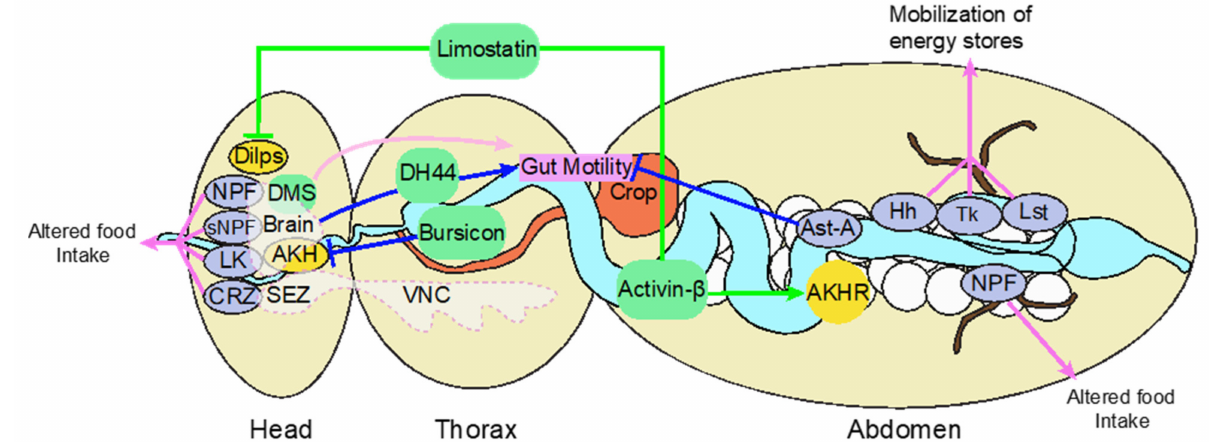
Figure 2. The fly gut is a major organ involved in nutrient-sensing to maintain metabolic homeostasis. The gut secretes multiple hormones and receives information from brain-derived hormones. These signals regulate functions, including gut motility, mobilization, and food intake. Thus, these hormones regulate the nutrients availability. Brain-derived peptides including Crz, DMS, Lk, NPF, sNPF regulate food intake, thereby regulating the quantity of nutrients reaching the GI tract. The gut hormones such as Hh, Tk, Ast-A, Lst, and NPF regulate the amount of food intake, mobilization of energy stores, and gut motility. Bursicon- α derived from EE cells promotes energy storage by inhibiting the production of glucagon-like hormone AKH. Limostatin, secreted by the gut endocrine cell and corpus cardiacum under nutrient-scarce conditions, controls the feeding behavior by suppressing DILP and causes mobilization of the energy via secretion of gut-derived activin- β . VNC is the ventral nerve cord. Neuropeptides controlling the feeding behavior of the fruit fly are released from the brain as well as from the gut. The gut-derived peptides are NPF, AST, DH, Tk, and Lst. The peptides derived from CNS are Hugin, NPF, DH, AST, Lk, limostatin, DILP, and